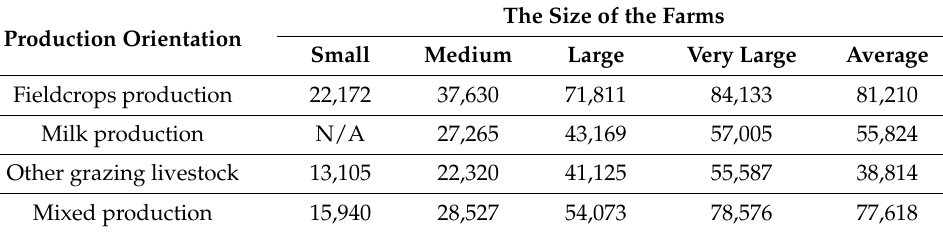
Table 7. Labour productivity (2015–2020